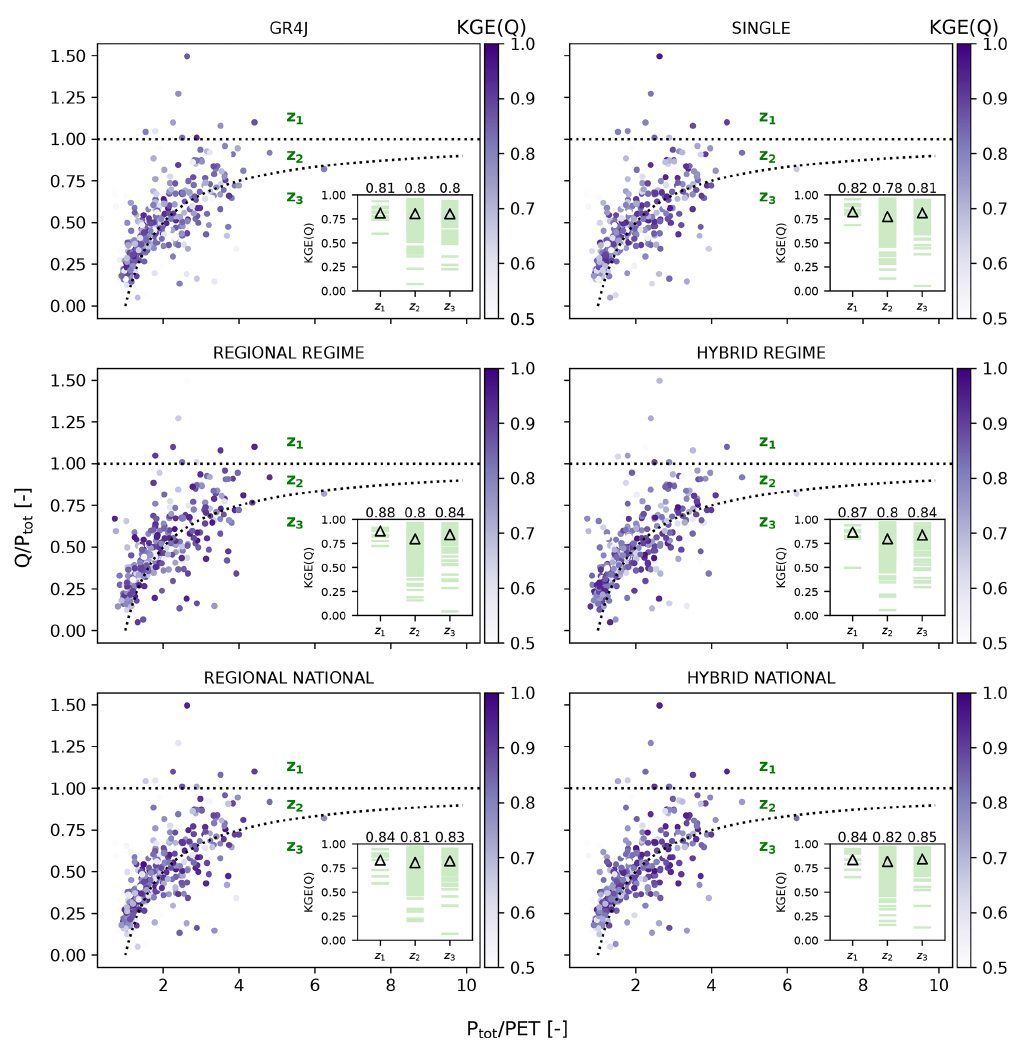
Figure 12. Variation in KGE scores with respect to the runoff ratio ( Q lower than 0.5 are shown in the same tone as the lower extreme of the colour bar. The inset plot within each panel shows the KGE scores of the catchments located in each of the z 1 (above the horizontal water limit line), z 2 (between the horizontal and curved lines), and z 3 (below the curved line) zones. The ( (cid:52) ) symbol and numbers in the inset plots represent the median KGE scores of the three zones. The KGE scores correspond to the test data, with the exception of the first 2 years, which constitute the warm-up period in GR4J and for which there are no